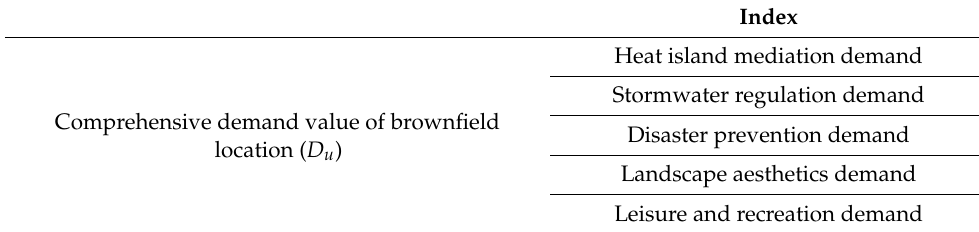
Table A2. Index system of comprehensive demand value of brownfield location ( D u ).